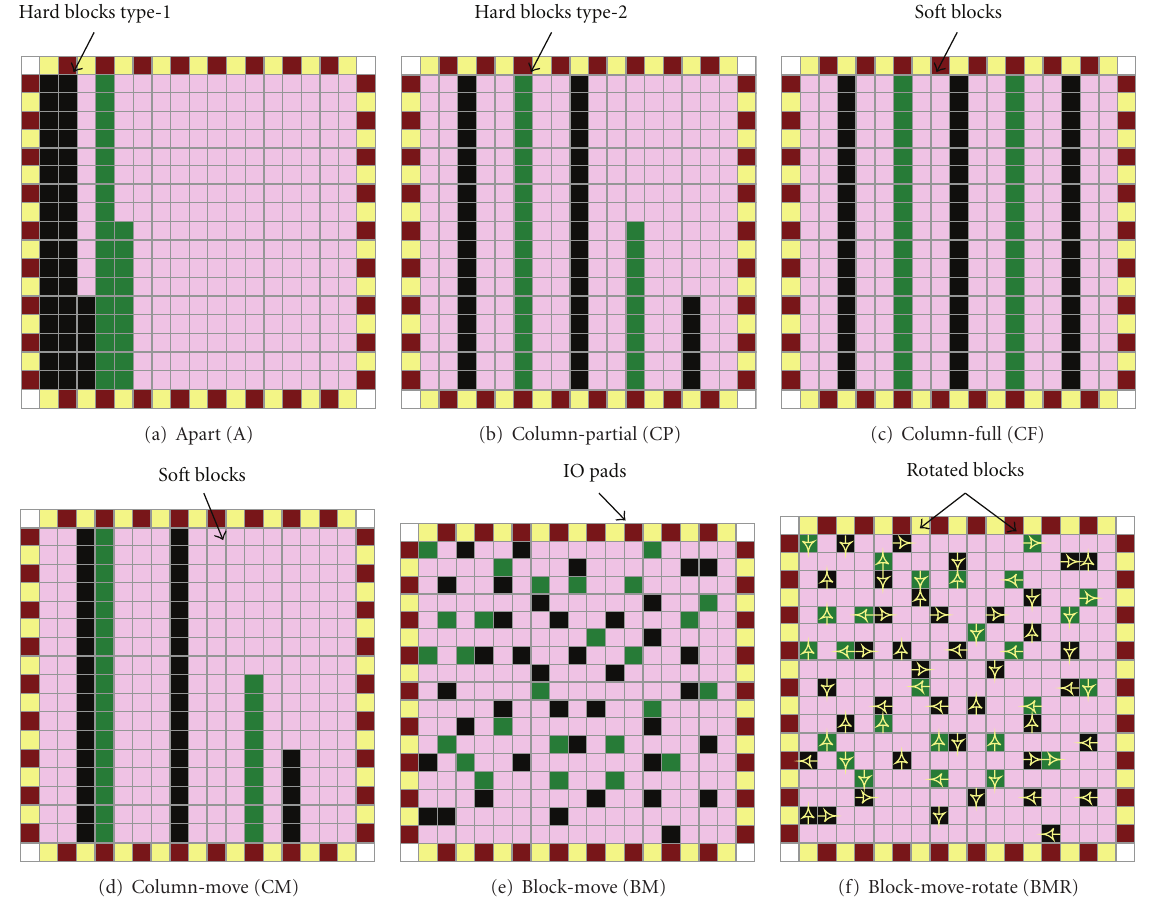
Figure 6: Floor-planning techniques.